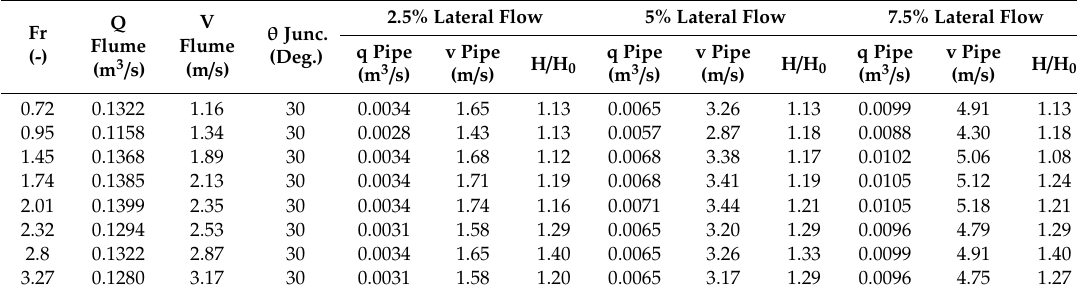
Table 8. Experimental results for the 30 ◦ junction in the narrow channel.